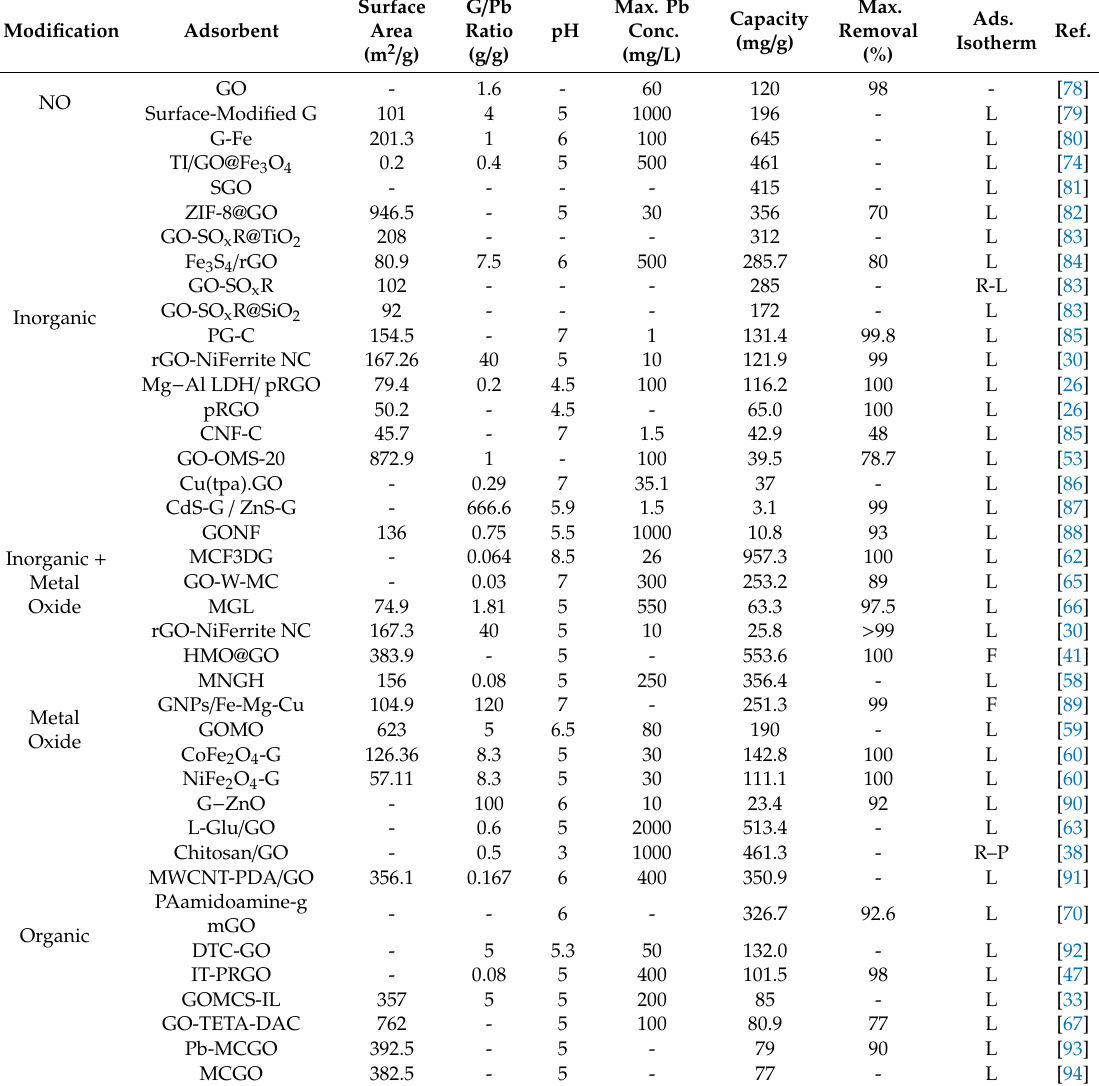
Table 3. Adsorption properties of multiple GO-based adsorbents used in Pb (II)